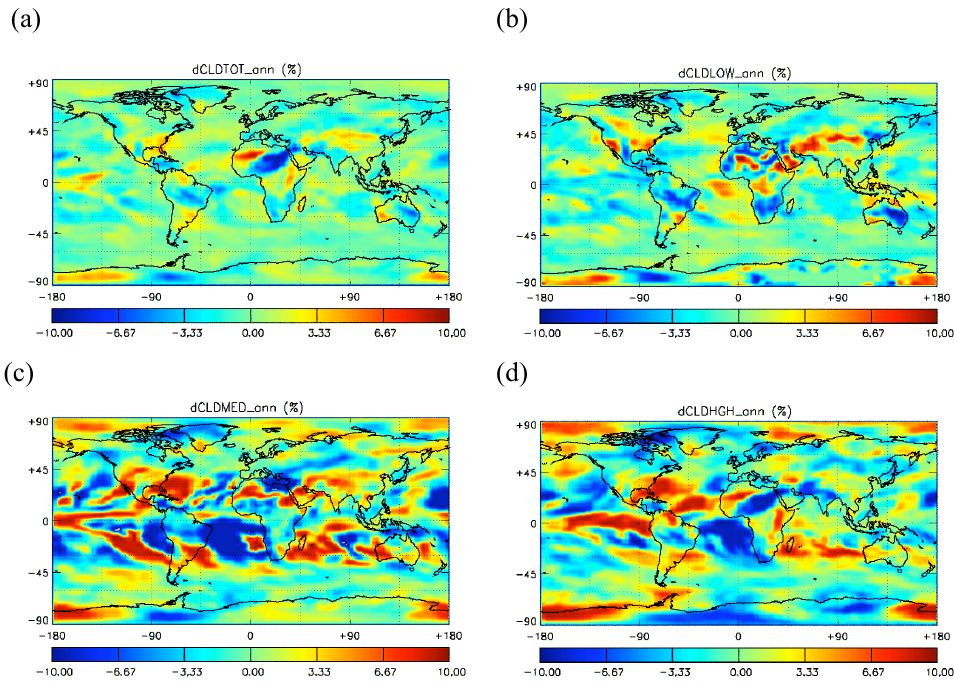
Fig. 9. Global distribution of annual mean of fractional differences in cloud distributions due to seasonal BBCA emissions in: (a) total cloud fraction (CLDTOT), (b) low-level cloud (CLDLOW), (c) mid-level cloud (CLDMED), and (d) high-level cloud